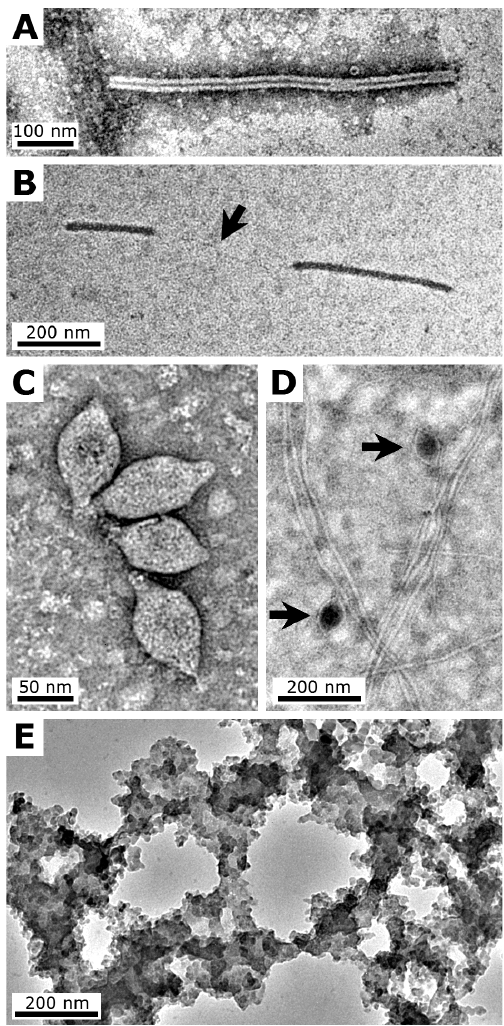
Fig. 1. (A–D) : TEM micrographs showing examples of the viruses used for this study. (A) SIRV2 particle; note the central cavity, sometime discontinued. (B) Fragments of SIRV2 particle on an un- stained grid; note the absence of visible features, and a viral DNA- protein filament that links the two fragments (arrow). (C) Aggre- gate of TPV1 particles. (D) PAV1 particles (arrows); note the pres- ence of remnant P. abyssi flagellas in the sample. (E) TEM mi- crograph showing example of the silica precipitate formed sponta- neously in the control sample, which contained no viruses, observed after 4days; unstained grid. All TEM micrographs were made at 200kV on grids negatively stained with uranyl acetate, unless oth- erwise